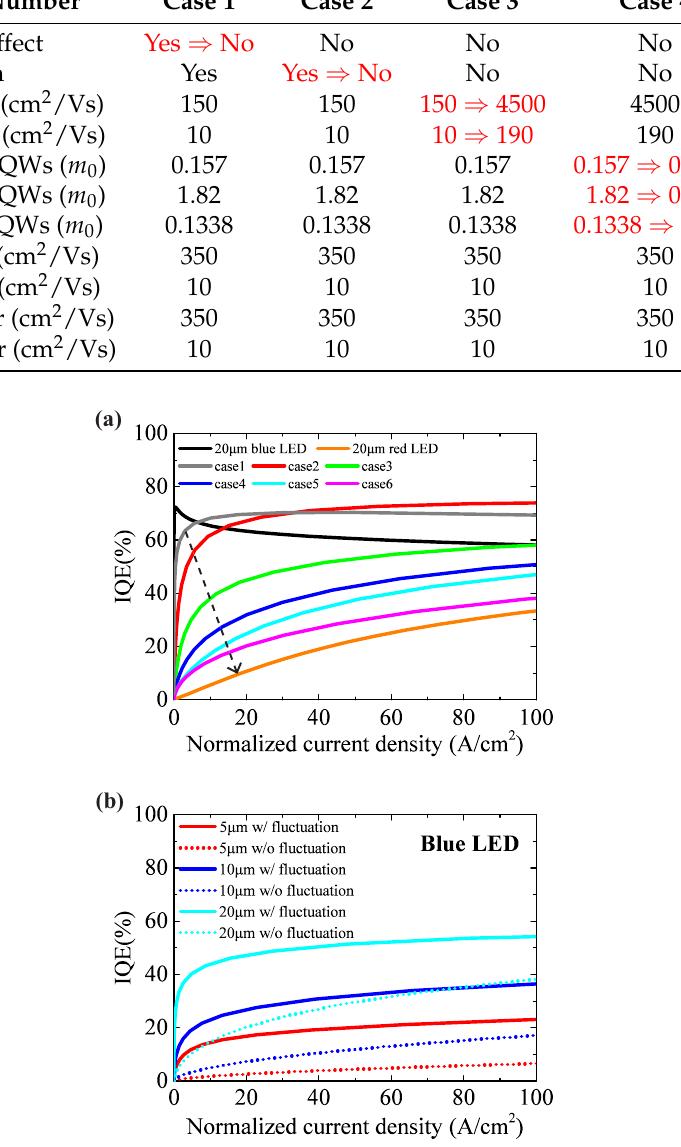
Figure 6. ( a ) Influence of different parameters on the IQE values of blue and red LEDs. The orange and black lines respectively indicate the 20- µ m blue and 20- µ m red LEDs presented as 2 cyan lines in Figure 3a,c. ( b ) IQE of blue LEDs in Case 6 for 3 types of sizes with and without random alloy